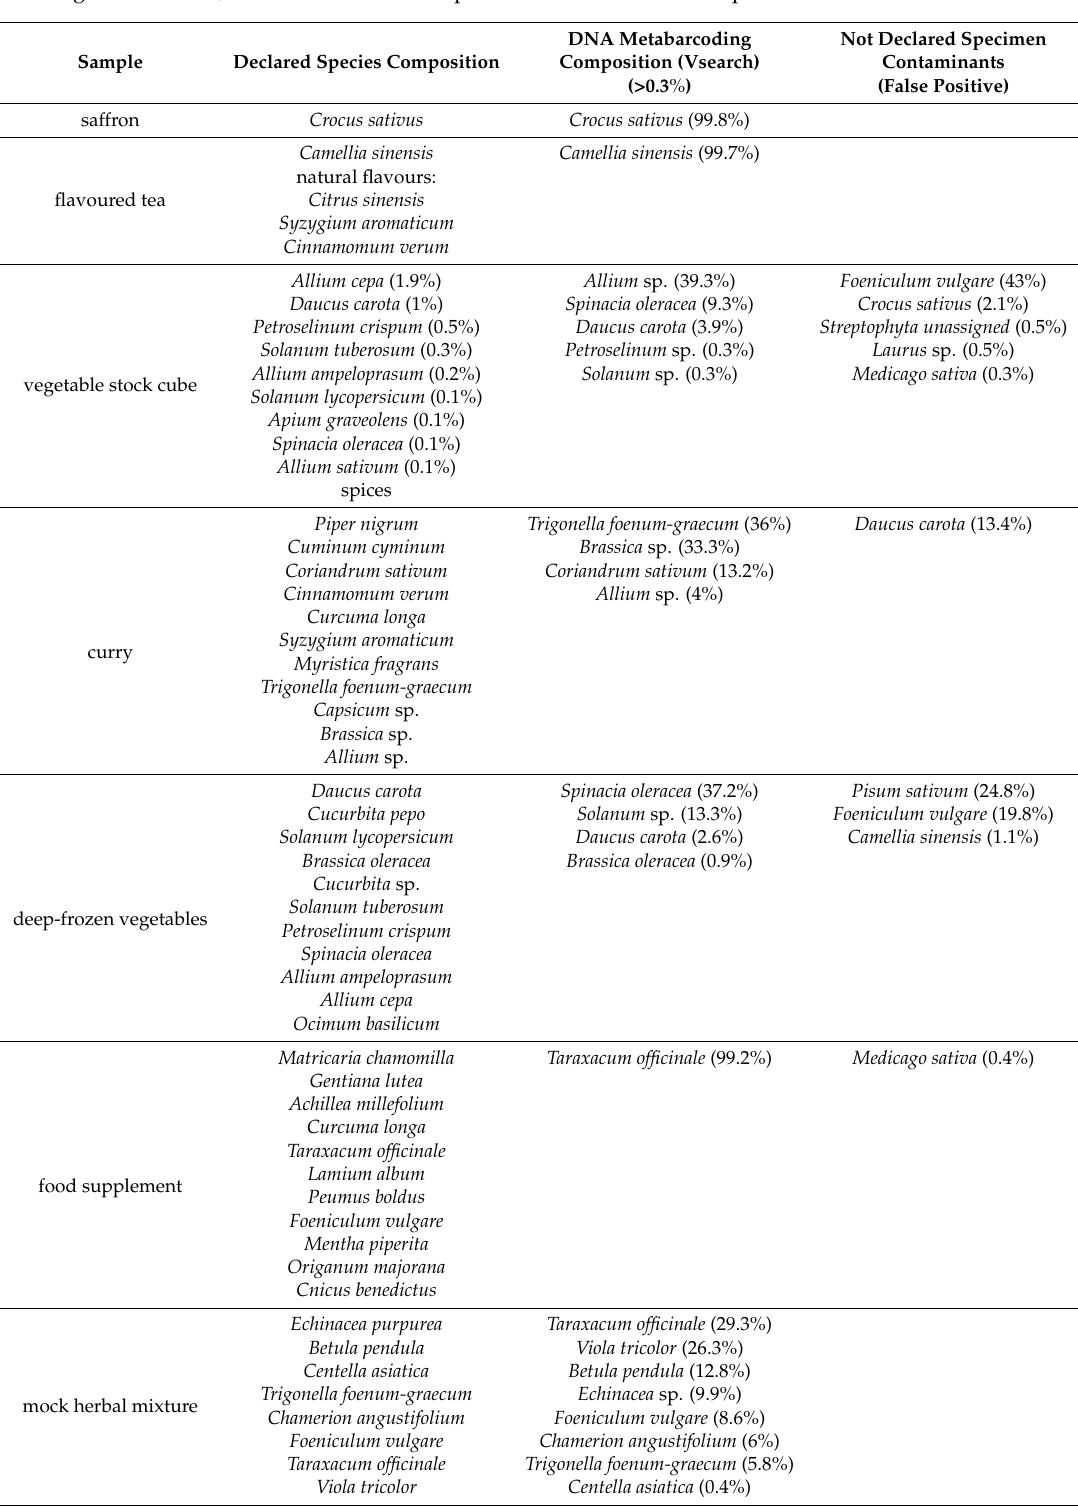
Table 2. List of processed food and artificial lab mix tested. When percentages were displayed in the ingredients label, the information was reported in the “declared composition”